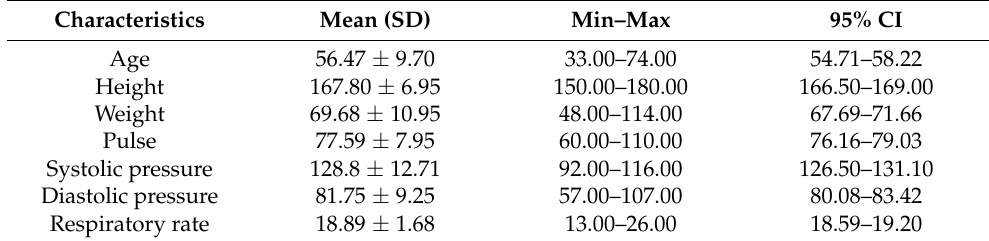
Table 1. Statistics of baseline characteristics of subjects.